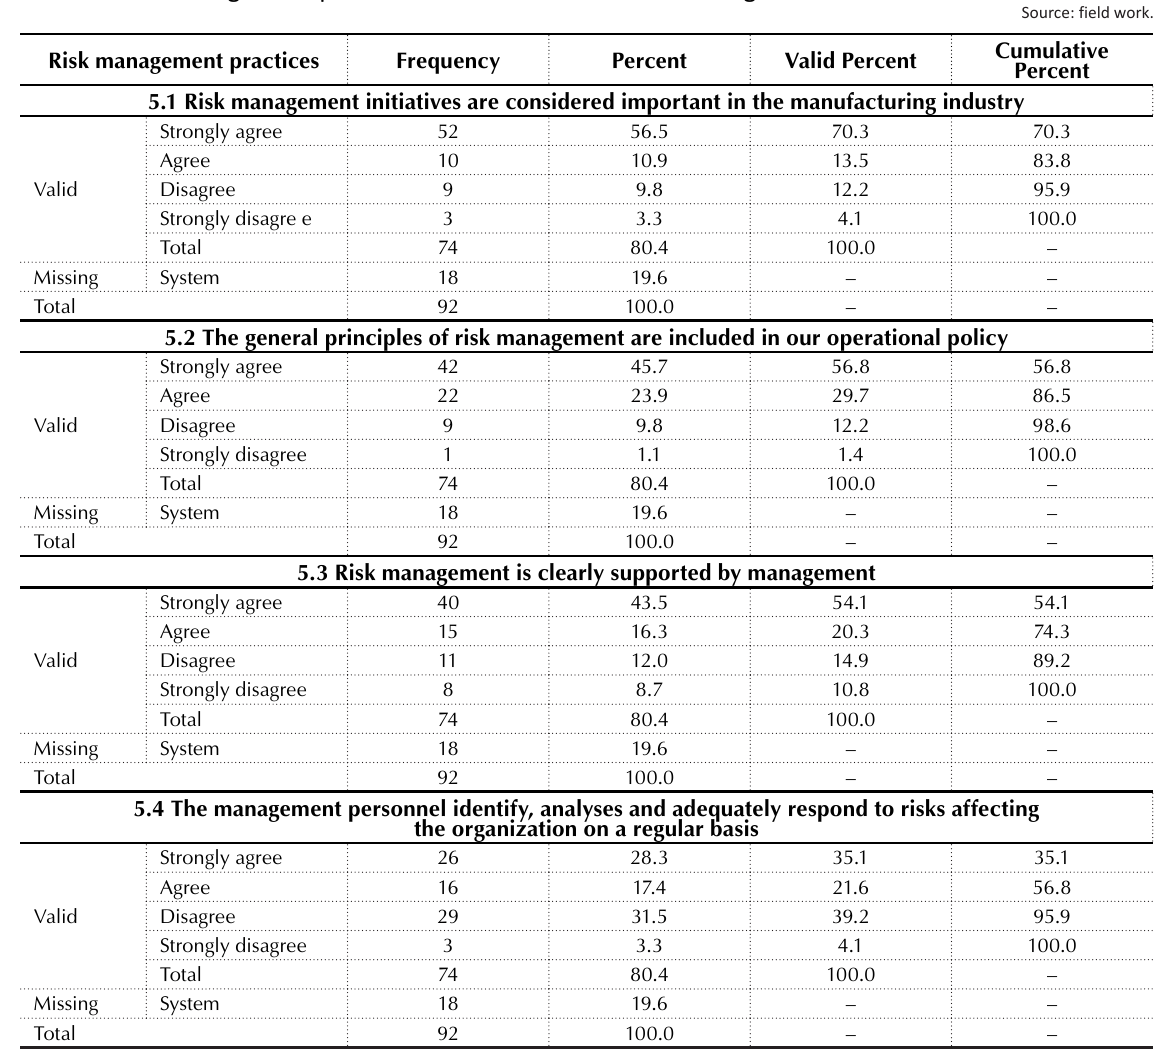
Table 5. Risk management practices of SMEs in the manufacturing sector